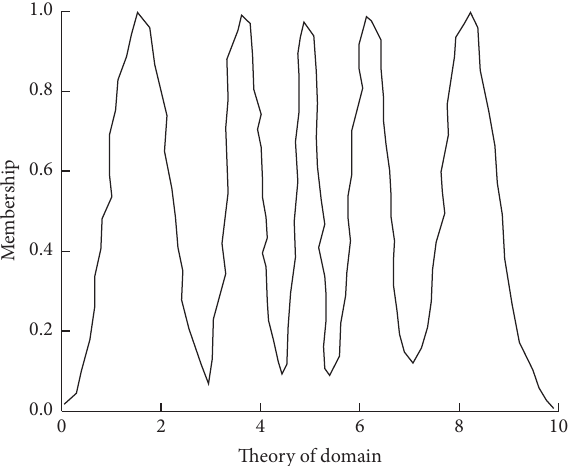
Figure 6: Relationship between domain and membership